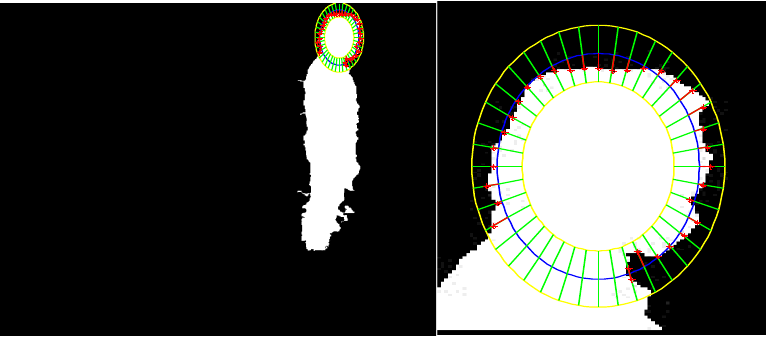
Figure 4. Head extraction result from the human silhouette in Figure